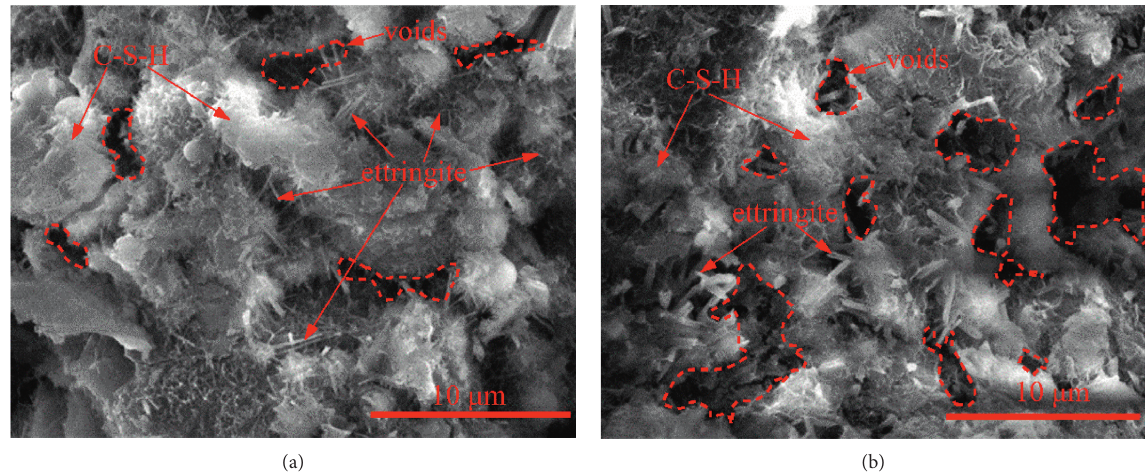
Figure 3: Microstructures (SEM) of (a) CB-HDB and (b) SB-HDB after curing for 3 days.